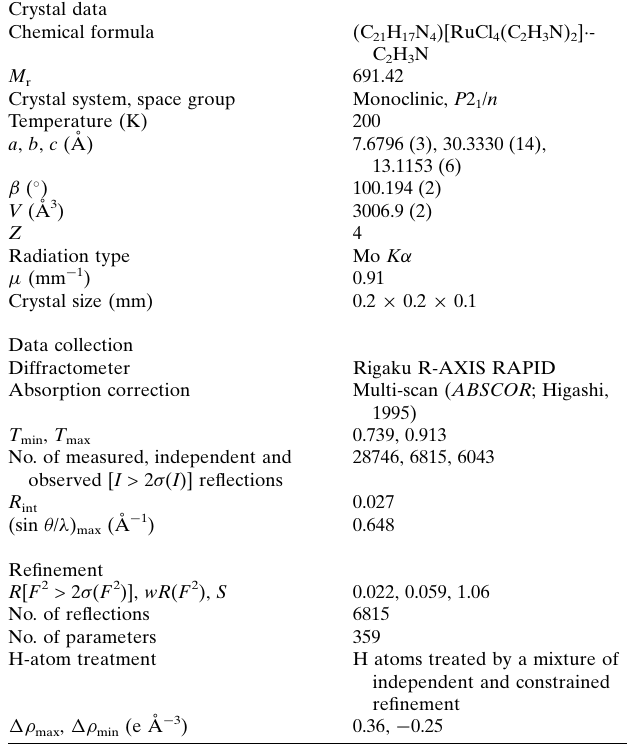
Table 2 Experimental details. Crystal data Chemical formula